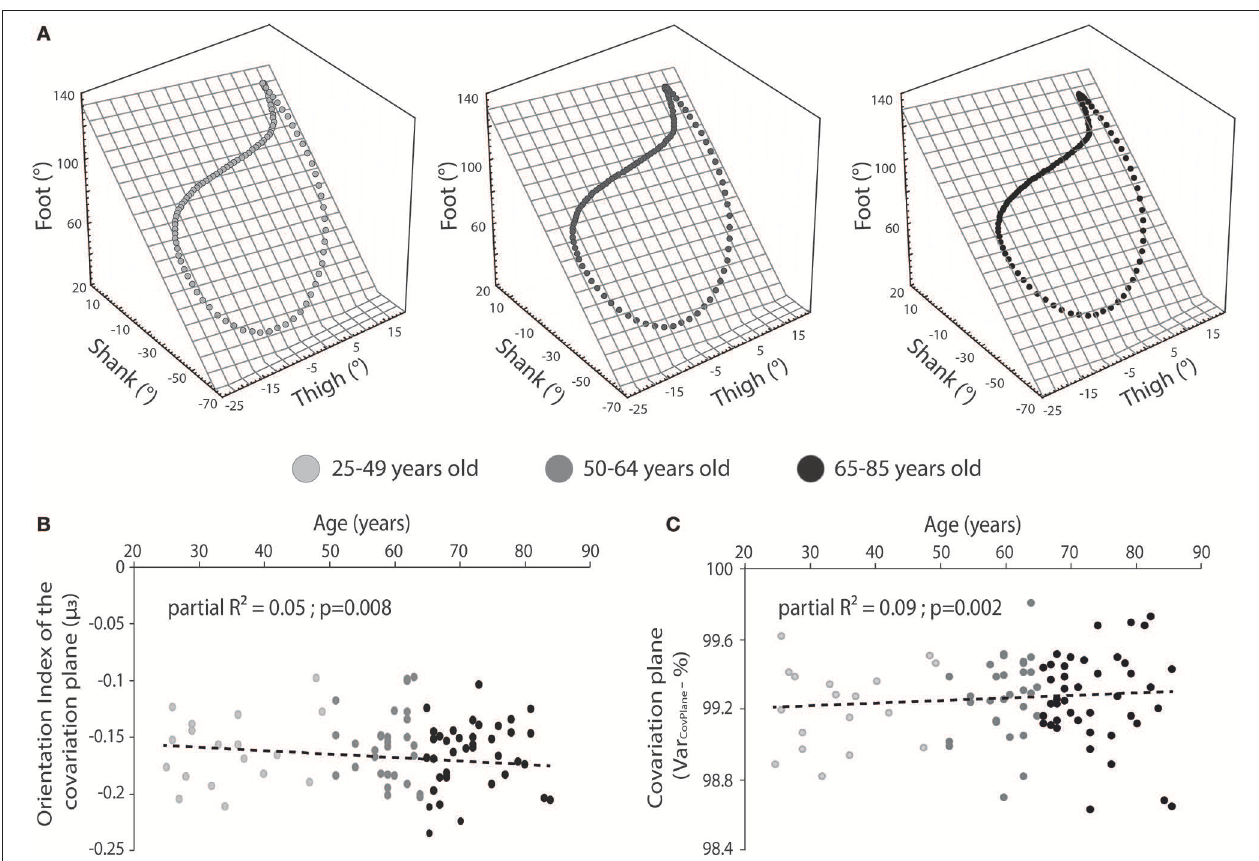
FIGURE 3 | (A) Representation of the mean planar covariation of the lower-limb segments for people of 25–49 (light gray)/50–64 (medium gray)/65–85 (dark gray) years old. (B) Relationship between the orientation (index) of the covariation plane and the age for people of 25–49 (light gray)/50–64 (medium gray)/65–85 (dark gray) years old. (C) Relationship between the variance of the covariance plane and the age for people of 25–49 (light gray)/50–64 (medium gray)/65–85 (dark gray) years old. Partial R 2 is provided. We choose to represent 3 classes of age in order to highlight change due to